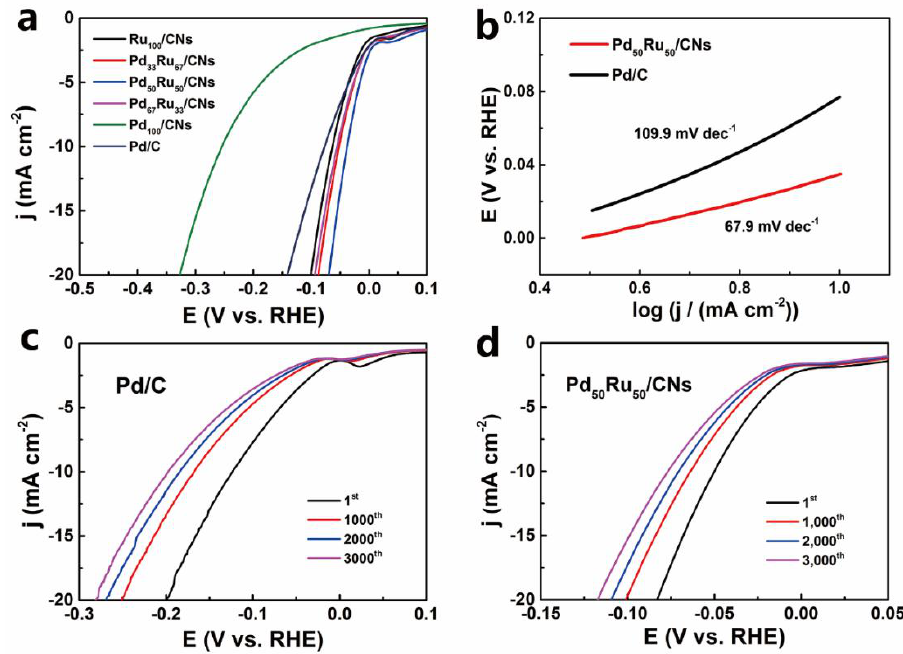
Figure 5. ( a ) The hydrogen evolution reaction (HER) polarization curves of the Pd 100-x Ru x /CNs series and Pd/C in 0.1 M KOH. ( b ) The corresponding Tafel plots of the Pd 50 Ru 50 /CNs and Pd/C catalysts. Polarization curves after continuous potential scans of ( c ) Pd/C and ( d ) the Pd 50 Ru 50 /CNs at 100 mV s −1 in 0.1 M KOH.